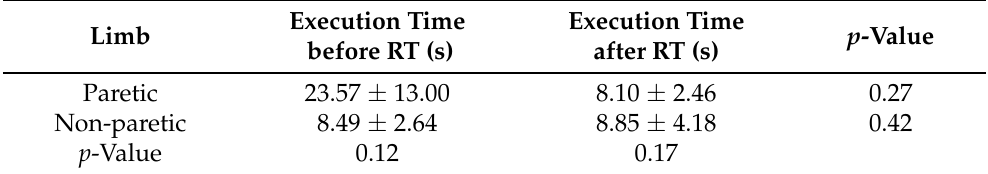
Table 6. Execution time of the Maximum Forward Reach Test before and after the rehabilita- tion